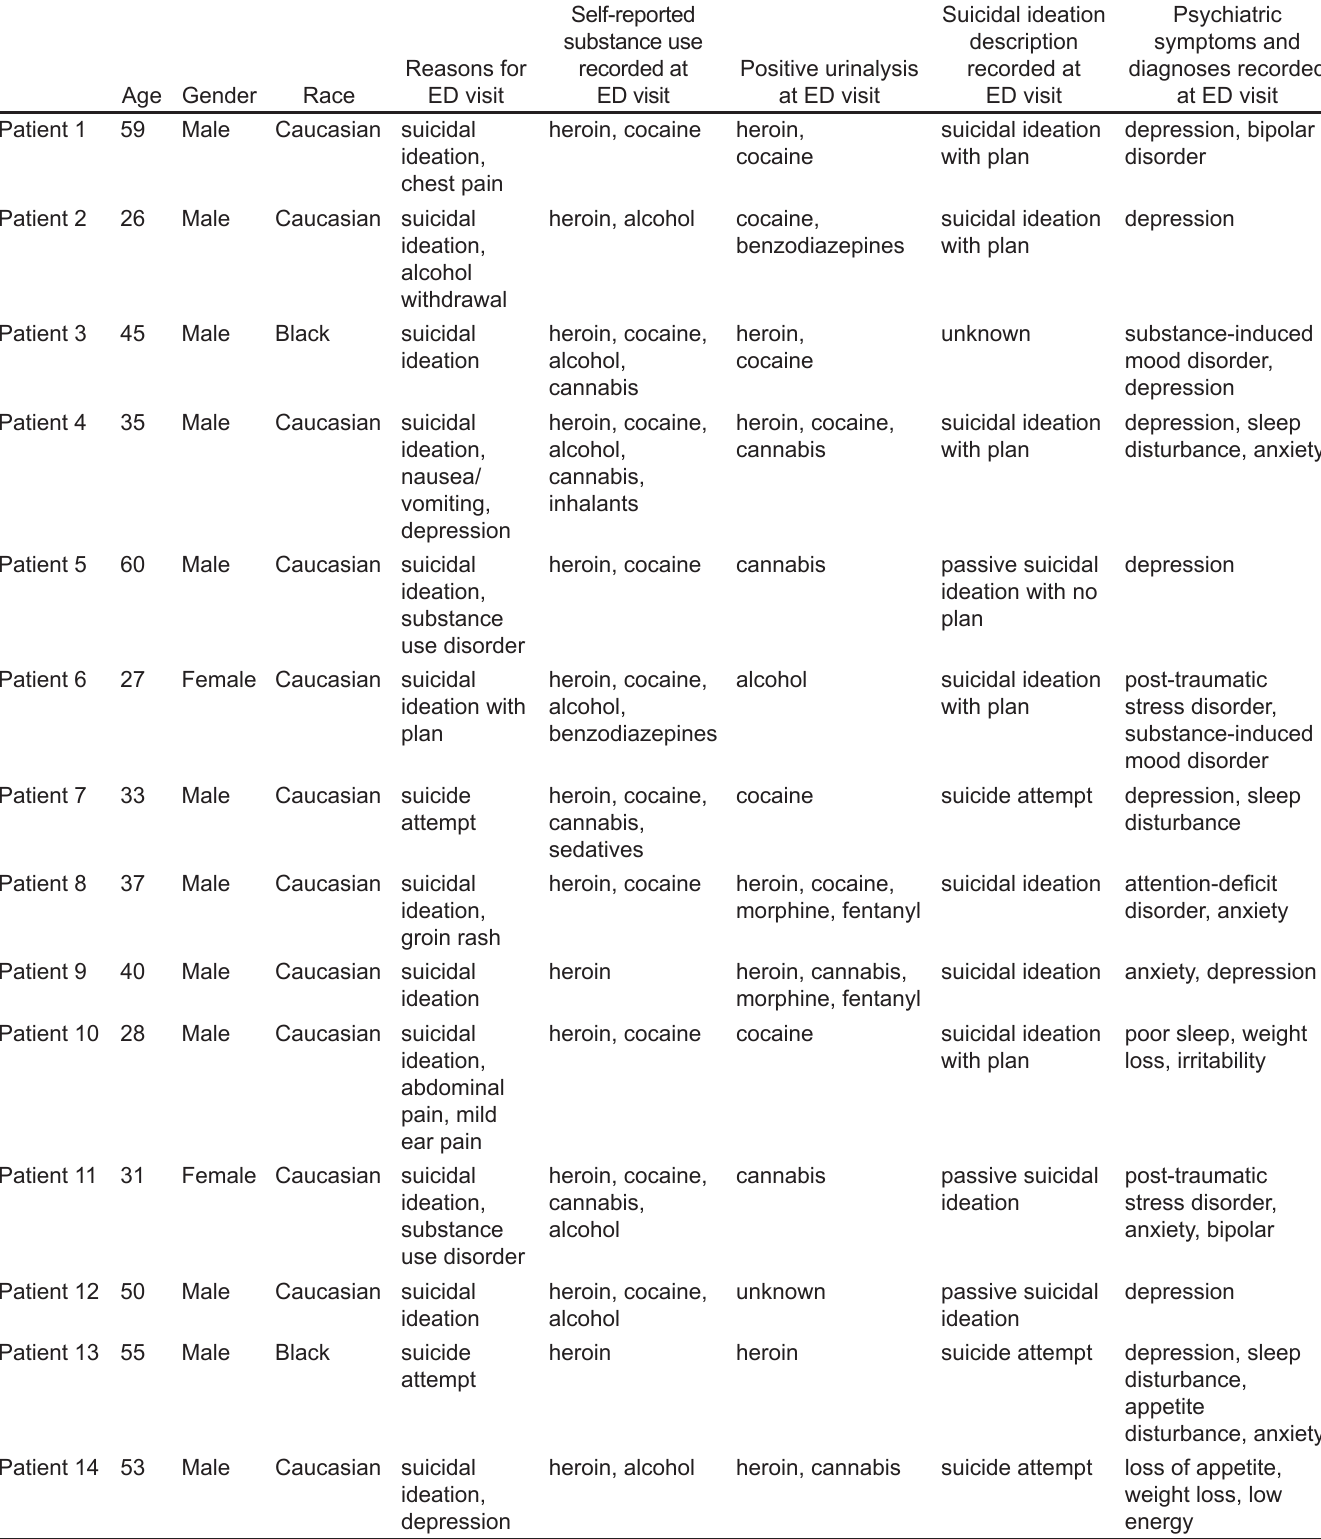
Table 1. Characteristics of 14 patients with opioid use disorder and suicidal ideation at presentation to the emergency department